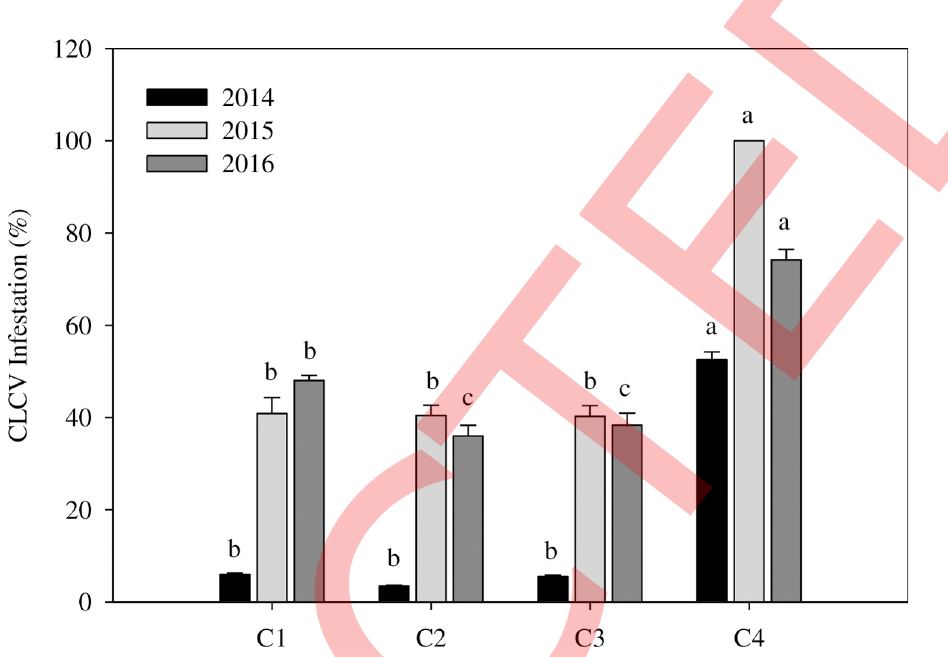
Fig 4. Cotton leaf curl virus incidence on cotton crop sown under various planting techniques. In X-axis legend, C 1 = cotton grown as sole crop, C 2 = relay cropped cotton in wheat (75 cm apart rows), C 3 = relay cropped cotton in wheat (150 cm apart rows) and C 4 = cotton planting after wheat harvesting.